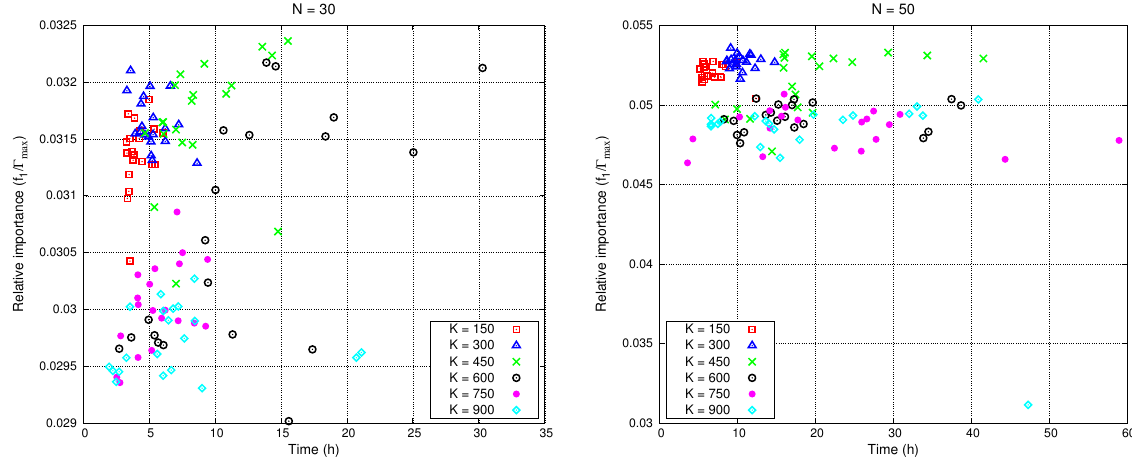
Figure 7. Relative importance sensed and computing time.